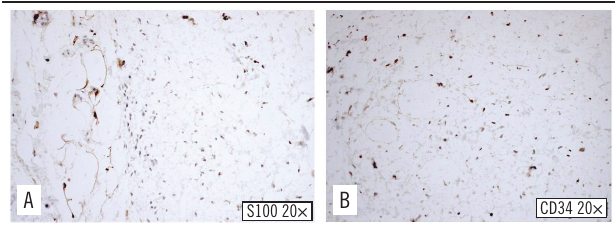
figurE 2 − Microscopical features of the spindle-cell lipoma with prominent myxoid change and cartilaginous differentiation A) areas of lipoblast-like cells in a myxoid stroma; notice the atypical stromal cells; B) transition between the myxoid and cartilaginous areas; C) presence of a fibrous capsule; D) cartilaginous tissue showing mature-appearing cells in a homogeneous stroma. HE: hematoxilin and eosin.